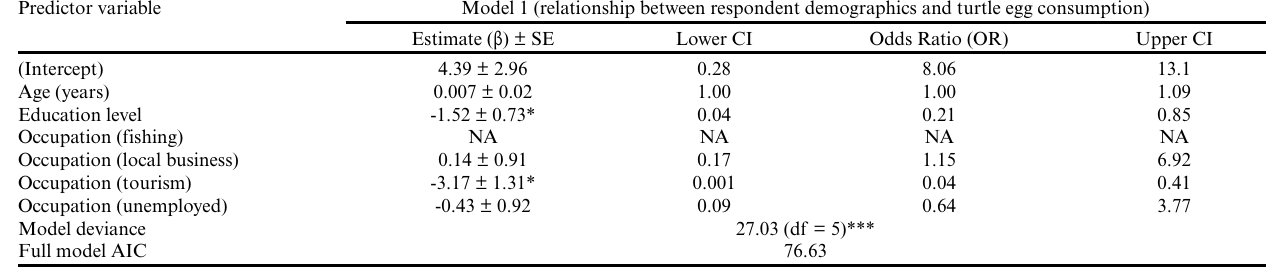
Table 4 . Results of the logistic regression model that explains the demographic factors influencing the respondents’ turtle egg consumption (n = 73). Values indicate the coefficient estimates ( β ) ± standard errors of estimates (SE), model deviance and the associated degrees of freedom (df), and p-value. The Akaike’s information criterion (AIC) of the model is also presented.